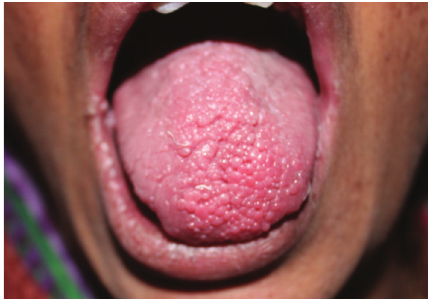
Figure 3: Cobblestone appearance of multiple confluent papules on the